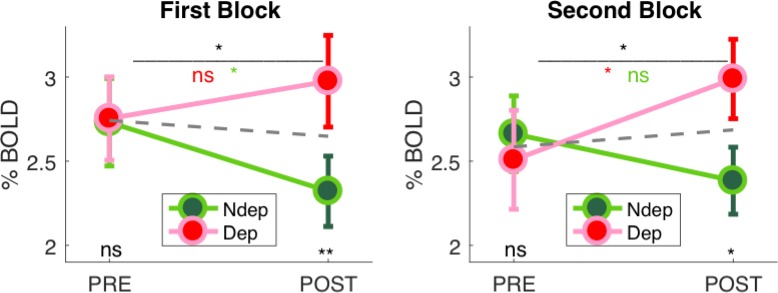
Split-half reliability of the deprivation effect in V1.Average V1 BOLD response to the band-pass noise stimulus with peak frequency 2.7 cpd, same as in Figure 1D but computed separately for each of the two stimulus repetitions that occurred in each scan (PRE and POST, to either eye). This essentially splits the dataset in half, and we show that both halves reveal a significant interaction between the factors time (PRE, POST deprivation) and eye (deprived, non-deprived; interaction term: first block F(1,18) = 7.53470, p = 0.01332, second block F(1,18) = 7.11116, p = 0.01572).